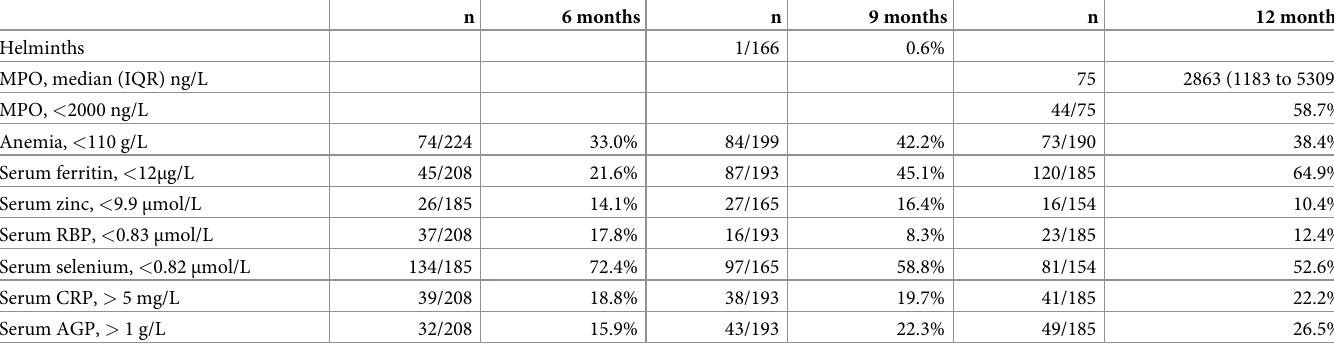
Table 3. Helminthiasis, MPO, biomarkers indicative of micronutrient deficiencies and inflammation at age 6, 9, and 12 months. n 6 months